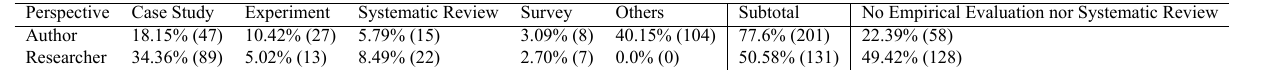
Table 2. Distribution of the Studies (%) - Authors’ vs. Researchers’